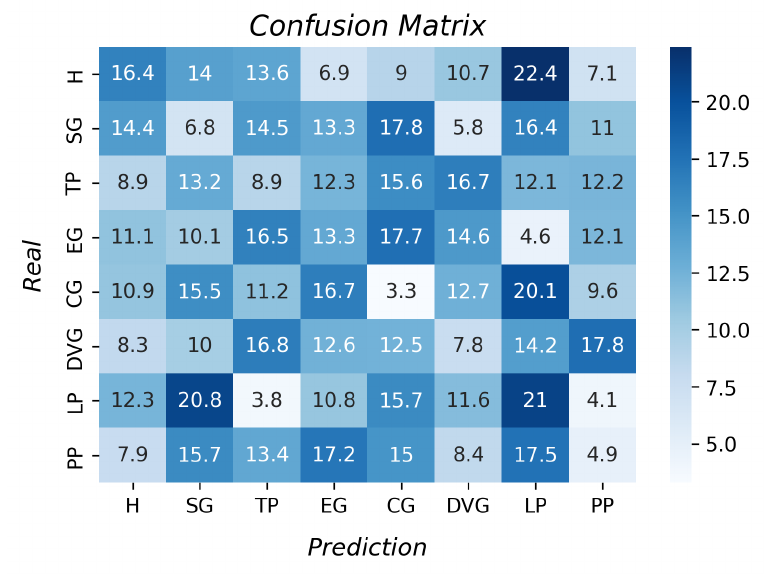
Figure 16. Accuracy per type of grasp for the KMC algorithm.